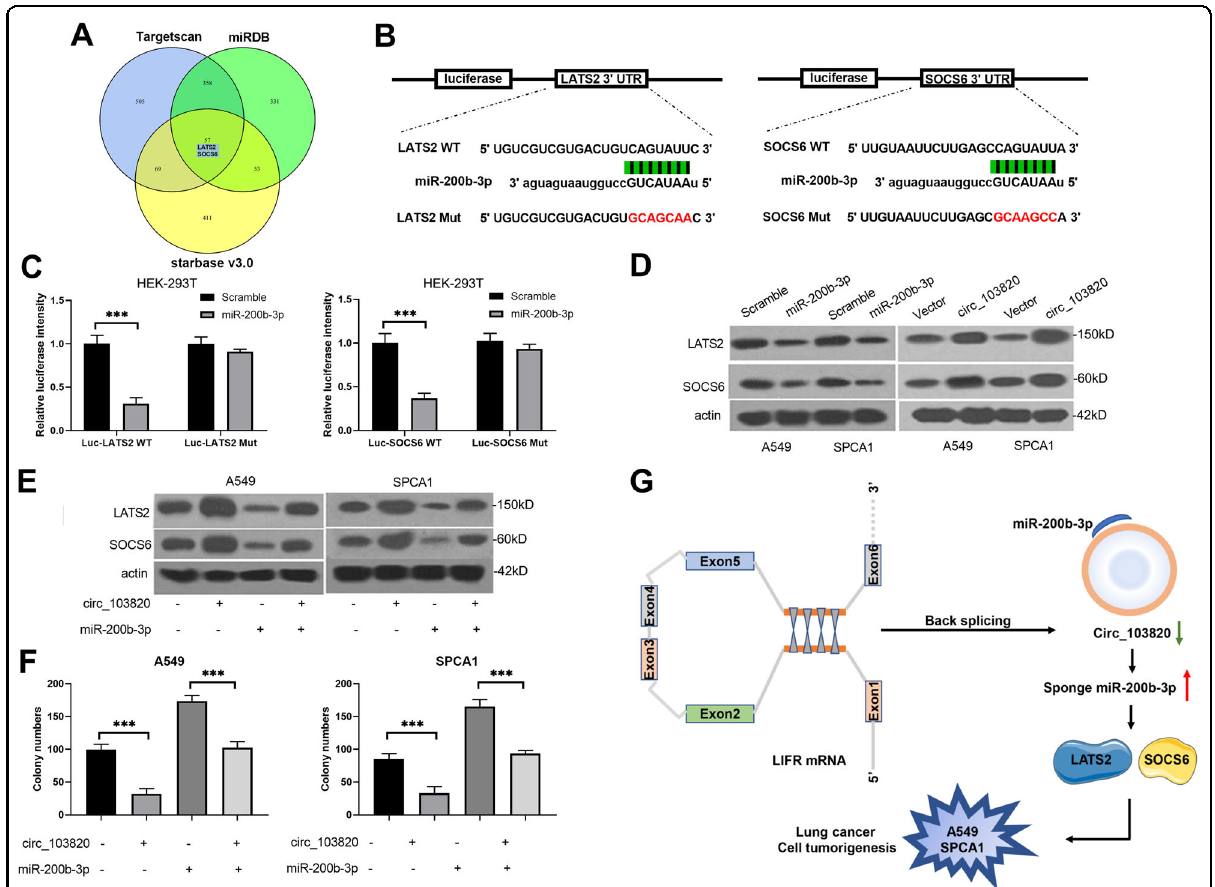
Fig. 7 miR-200b-3p directly targeted LATS2 and SOCS6. A TargetScan, miRDB and starBase v3.0 were applied to predict the downstream target genes of miR-200b-3p. B Binding sequences for miR-200b-3p in the 3 ′ -UTR of LATS2 and SOCS6. C The targeting relationship between miR-200b-3p and LATS2 and SOCS6 was analyzed by luciferase reporter gene assay in A549 cells. D Western blotting analysis of LATS2 and SOCS6 expression in miR-200b-3p- or hsa_circ_103820-overexpressing A549 and SPCA1 cells. E After A549 and SPCA1 cells were cotransfected with hsa_circ_103820 plasmid or/and miR-200b-3p mimics, LATS2 and SOCS6 expression was assessed by western blot assay. F Cell proliferation was examined using a colony formation assay in A549 and SPCA1 cells after cotransfection with hsa_circ_103820 and miR-200b-3p. G A schematic diagram was generated to show the hsa_circ_103820/miR-200b-3p/LATS2/SOCS6 axis in lung